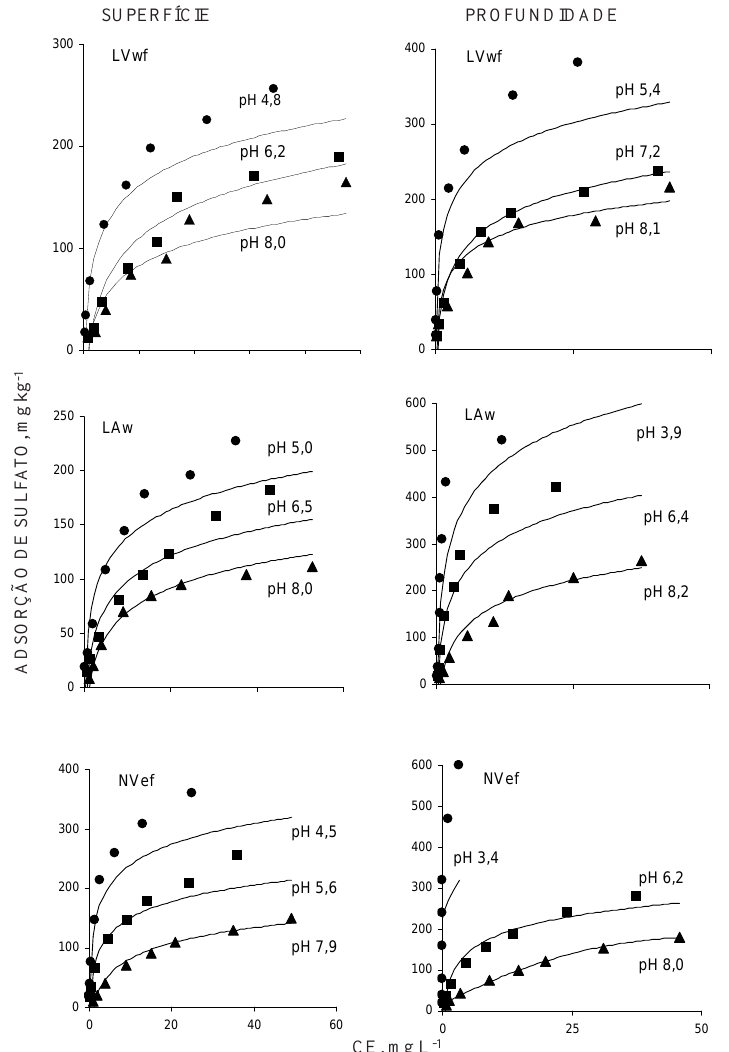
Figura 3. Adsorção de sulfato determinada (marcadores) e simulada pelo modelo tetraplanar (linhas) em função da concentração de equilíbrio (CE), para diferentes valores de pH para o Latossolo Vermelho ácriférrico (LVwf), Latossolo Amarelo ácrico (LAw) e Nitossolo Vermelho eutroférrico